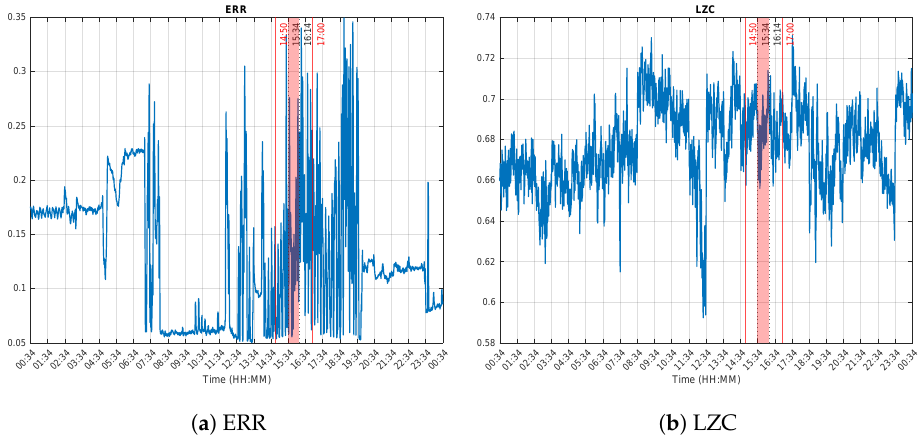
Figure 4. Complexity features. The experiment was performed between 14:50 and 17:00 (red vertical lines). The dotted lines at 15:34 and 16:14 delimit ∆ t , the time during which the experimenter reported that the patient was correctly answering the questions he was asked. In both cases, an increase was observed especially during the experiment. Higher complexity values indicate an activated